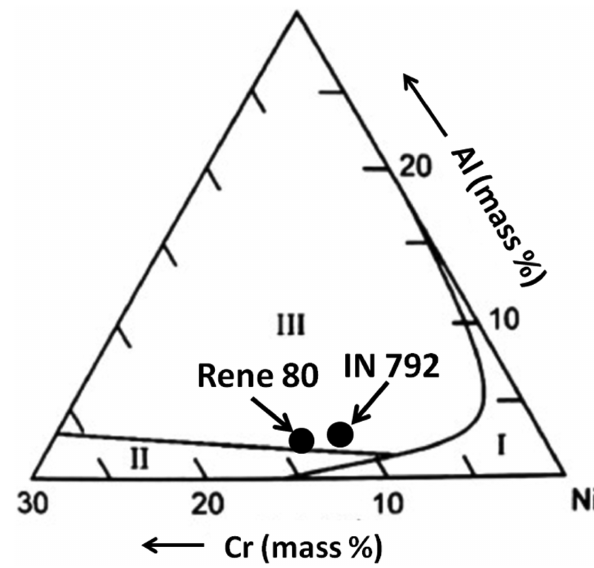
Figure 4: Oxidation map for Ni – Cr – Al alloys [4] showing fields of various oxide scale type formation as function of alloy Cr and Al contents at 1,000 – 1,100°C: I – NiO forming alloys, II – Cr 2 O 3 forming alloys, III – Al 2 O 3 forming alloys. Superimposed are Cr and Al con- tents of Rene 80 and IN 792.